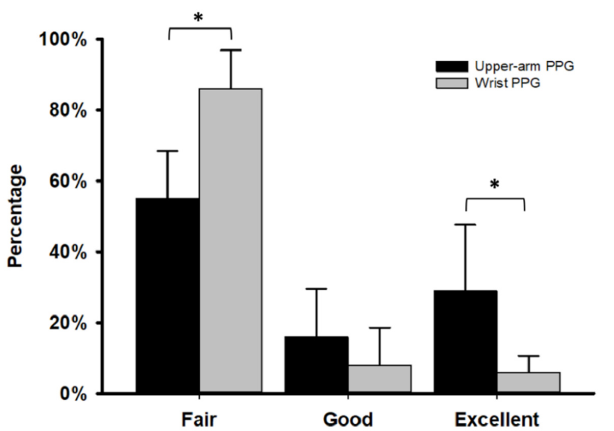
Figure 7. Distribution of the three quality levels in PPG signals measured at the upper arm (black column) and wrist (gray column). The bar plot represents mean and SD (error bars). The upper-arm PPG generally had a higher proportion of excellent (29 ± 16%) and good (16 ± 12%) pulses, while the wrist PPG had a higher proportion of fair (86 ± 9%) pulses. The difference in proportions between the two quality levels (i.e., fair ( p = 0.029) and excellent ( p = 0.029)) was statistically significant (* p <